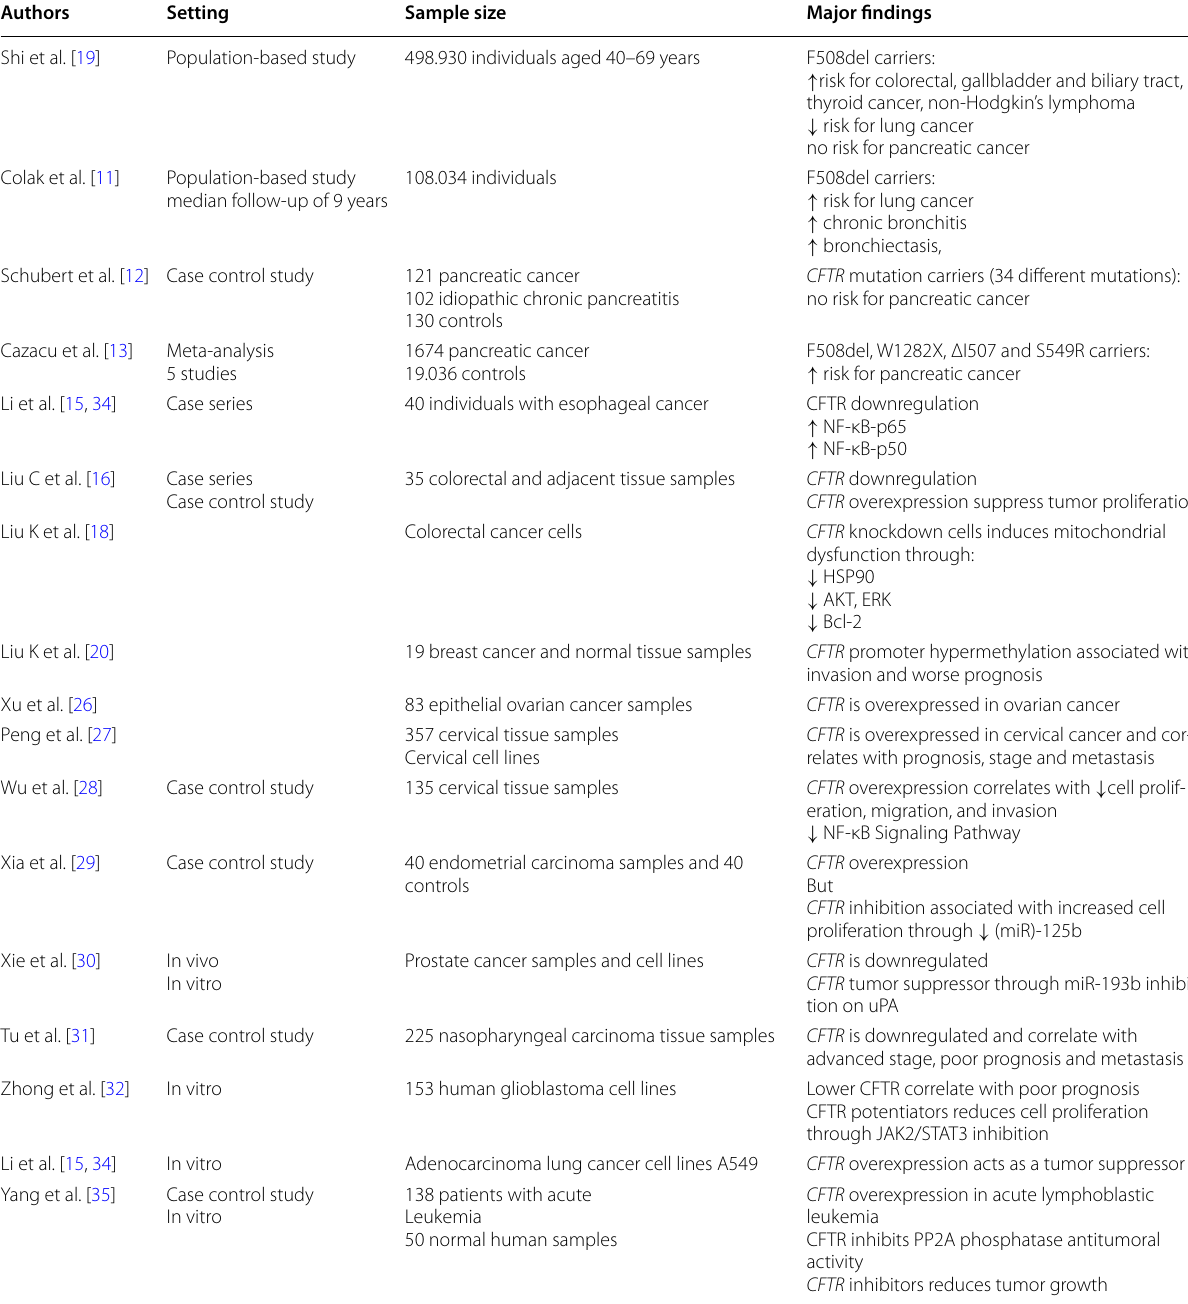
Table 1 Summary of main studies about CFTR and cancer